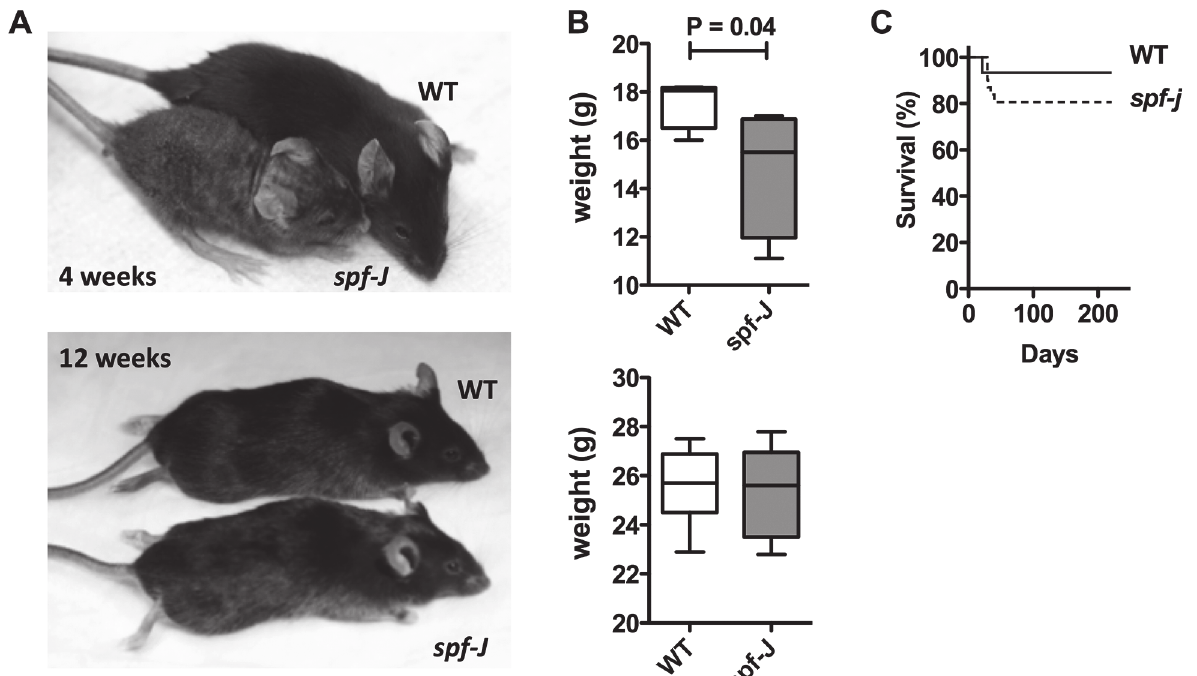
Figure 2. Phenotypic appearance, weight and survival on spf-J males. A) Photos of spf-J at 4 weeks (top) and 12 weeks (bottom). B) Weight of spf-J (N = 8) and WT (N = 9) at 4 weeks (top) and 12 weeks (bottom). C) Morbidity analysis for spf-J (N = 10) versus WT littermates (N = 10). Horizontal hatched bar indicates P < 0.05. WT –